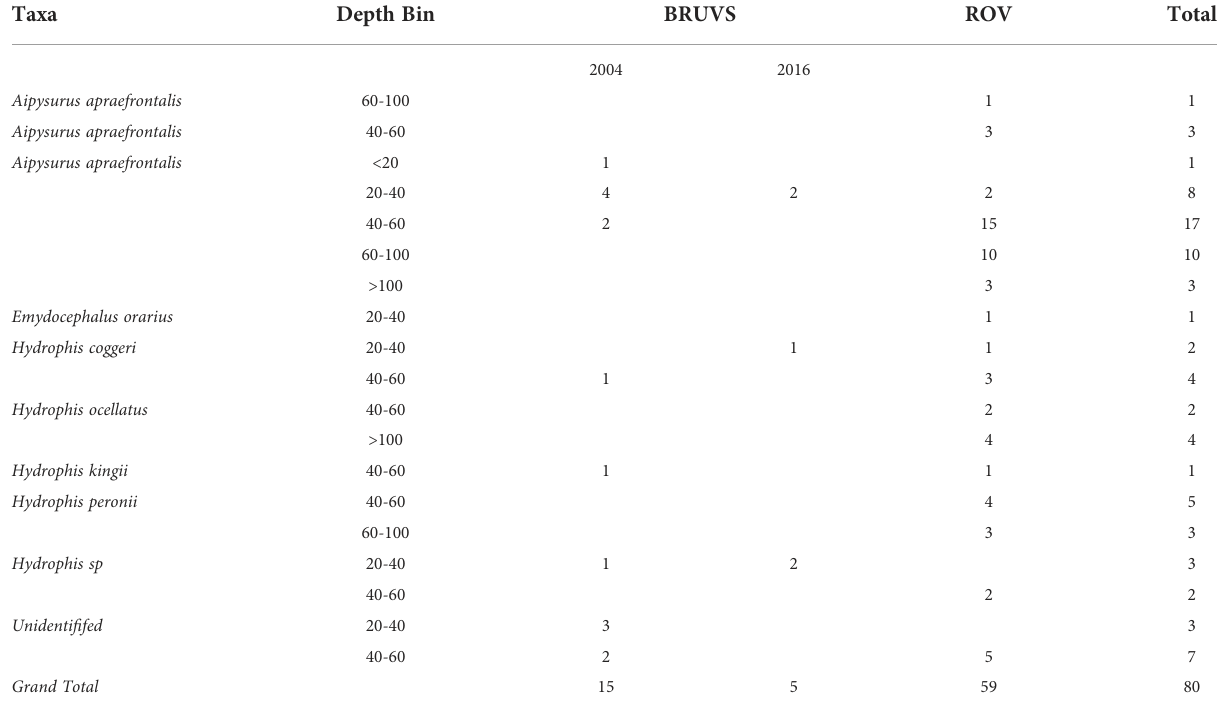
TABLE 1 Sea snake taxa identi fi ed at Ashmore reef using BRUVS survey in 2004 and 2016, a ROV survey in